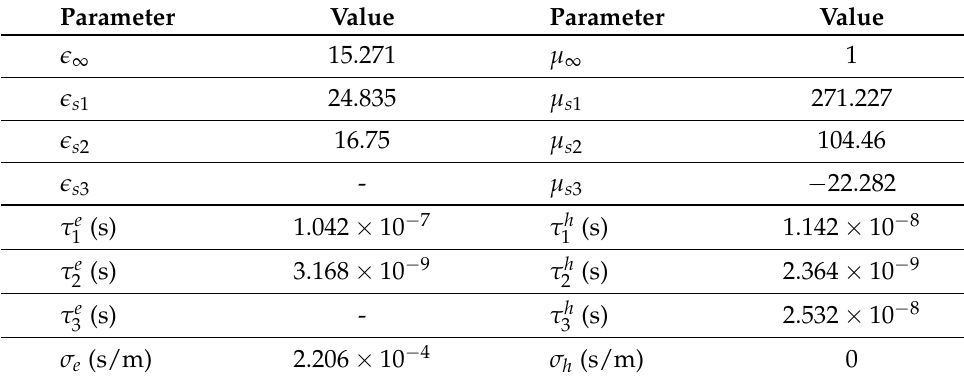
Table 1. Debye’s second order model parameters for ferrite used.